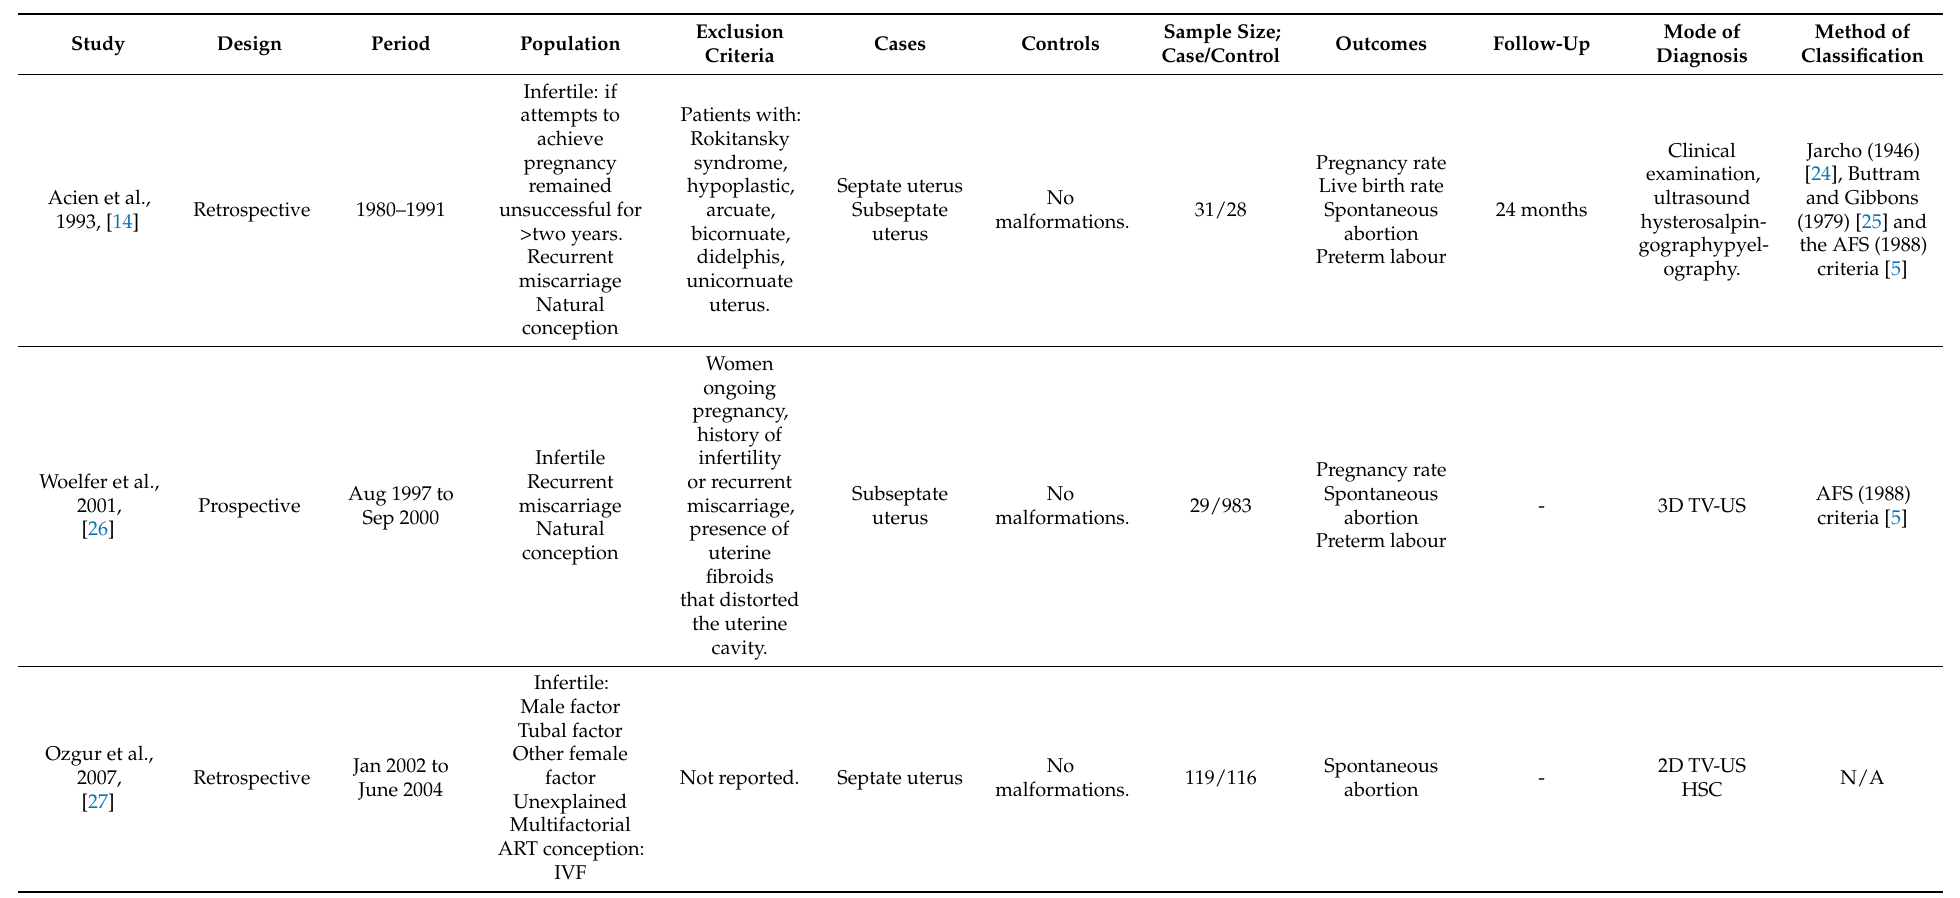
Table 1. General features of studies included in the meta-analysis: Uterine septum versus controls (no